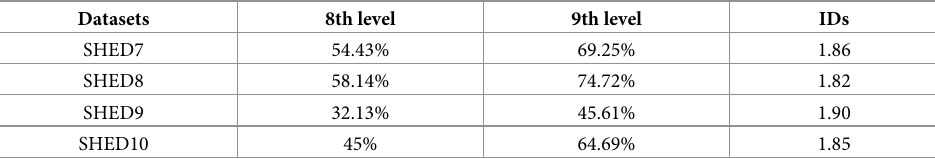
Table 4. Ratio of leaves and IDs.